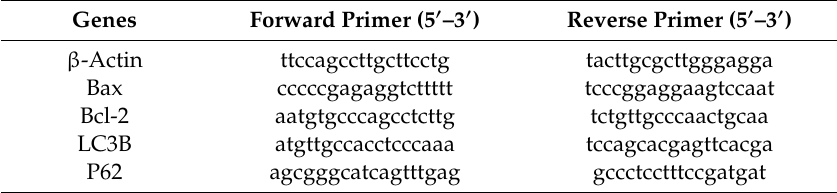
Table 2. Sequences of the primers used for quantitative real-time polymerase chain reaction (qRT-PCR). Genes Forward Primer (5 (cid:48) –3 (cid:48)